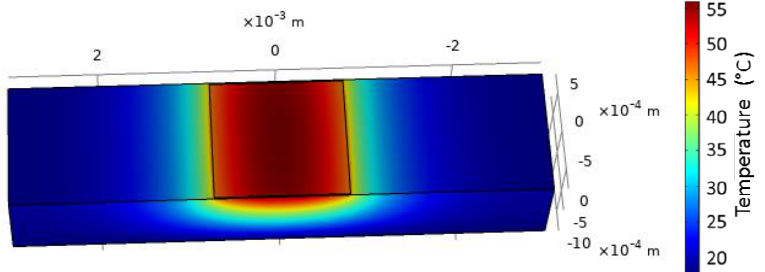
Figure 6. Narrowed surface area modeling window, under the same current injection conditions as the full sensor (see Figure 5).